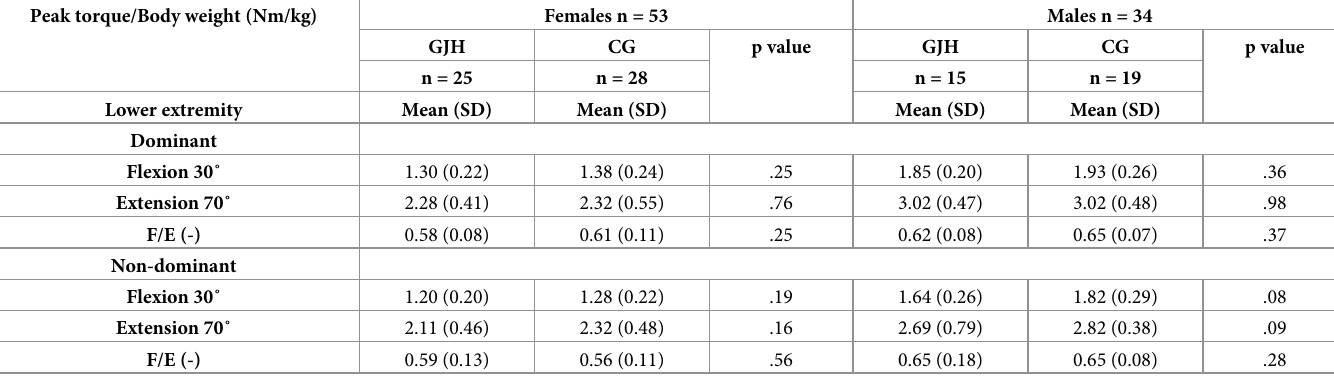
Table 5. The comparison of peak torque under isometric conditions obtained by females and males with and without generalized joint hypermobility. Peak torque/Body weight (Nm/kg)